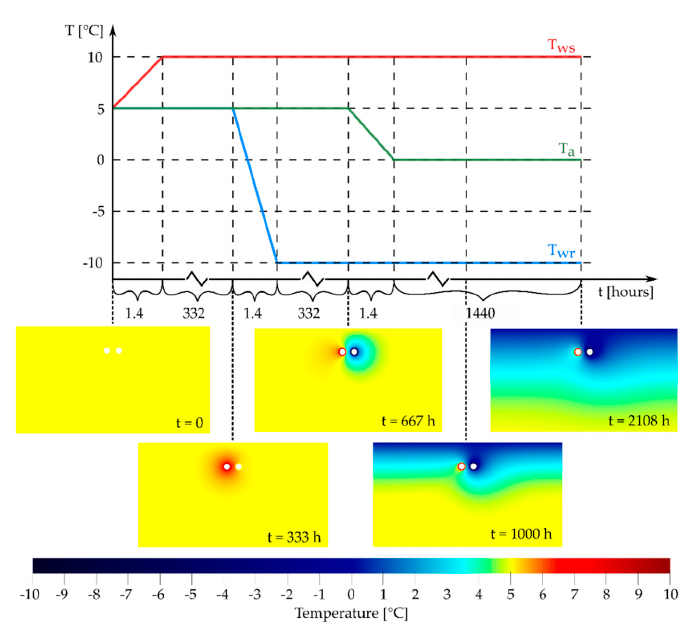
Figure 2. Driving temperatures used for training and the e ff ect on temperature distribution inside the considered domain. The nominal values do not reflect real operational conditions, since relative values are important in inducing heat